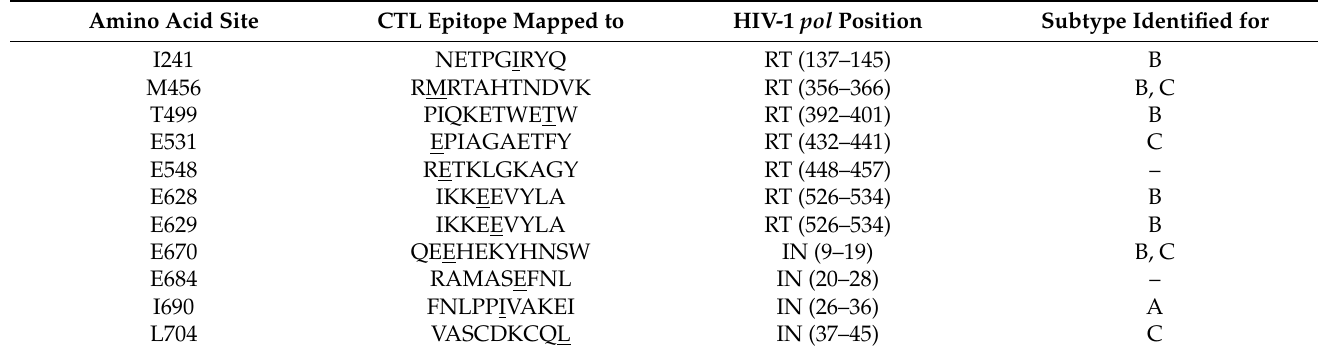
Table 2. HIV-1 pol CTL epitopes and location of amino acid mutations with different distribution between recent and chronic infection stages.